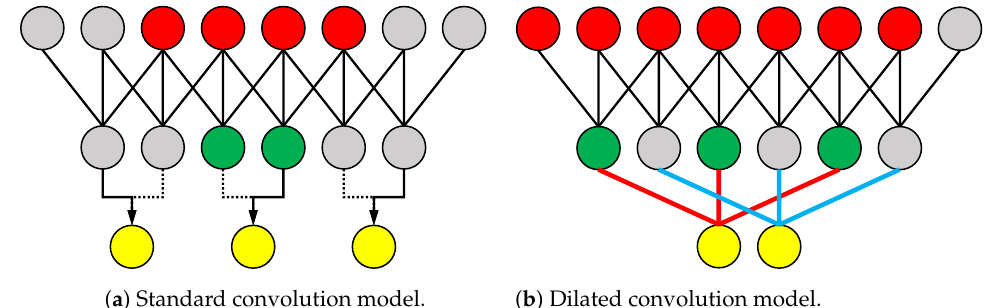
Figure 3. Comparison of two convolutional